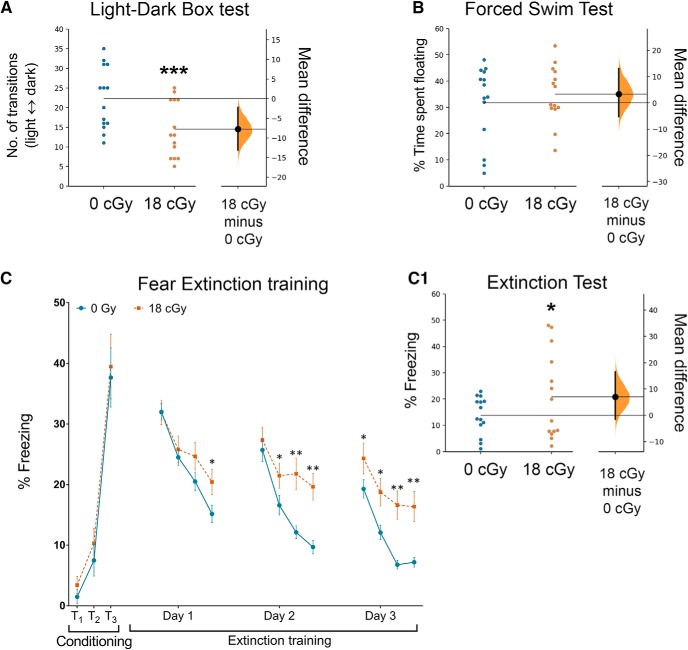
Space-relevant, low dose-rate neutron irradiation elicits anxiety-like behavior. A, Neutron irradiation increases anxiety-like behavior as the irradiated mice exhibit reduced numbers of transitions between the light and dark chambers in the LDB test. B, Irradiated mice did not show depression-like behavior on the FST. C, Last, neutron irradiation compromised fear extinction memory function. Mice showed elevated freezing following a series of three tone–shock pairings (0.6 mA, T1–T3). Subsequently, 24 h later, fear extinction training was administered every 24 h (20 tones) for 3 d. All mice showed a gradual decrease in the freezing behavior (Days 1–3), however, irradiated mice spent a significantly higher time in freezing compared with controls. Twenty-four hours after extinction training, control mice showed abolished fear memory compared with neutron-exposed mice (C1, inset). Data are presented as mean ± SEM (A–C, C1, N = 14 per group). *p < 0.05, **p < 0.01, ***p < 0.001 (Mann–Whitney’s two-tailed, nonparametric t test) compared with controls.